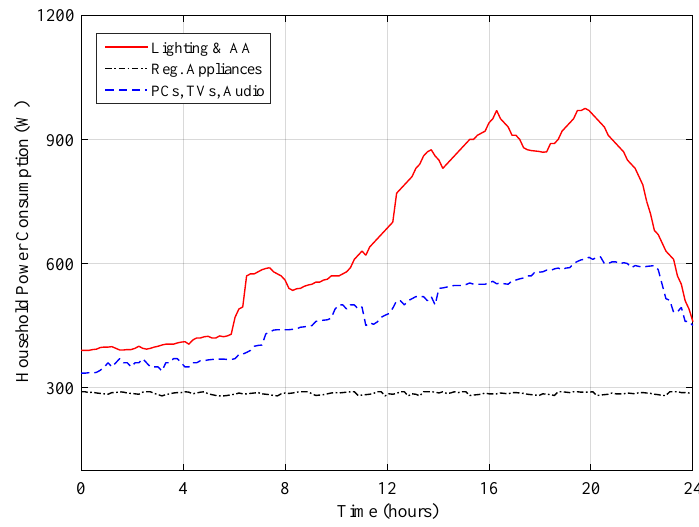
Figure 8. Differentiated load curve for different electricity consuming activities.